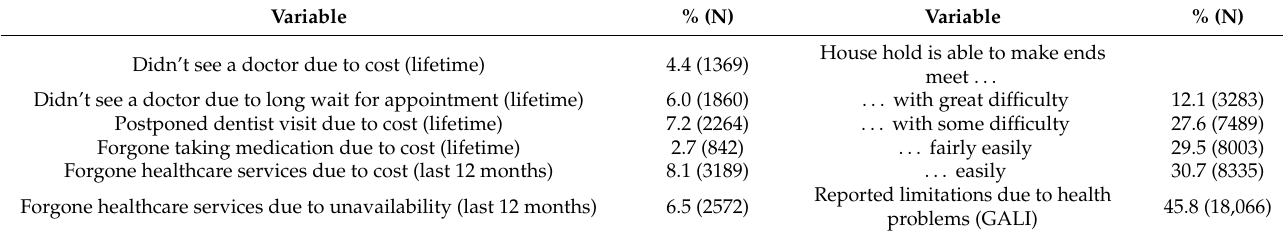
Table 1. Descriptive characteristics of predictive